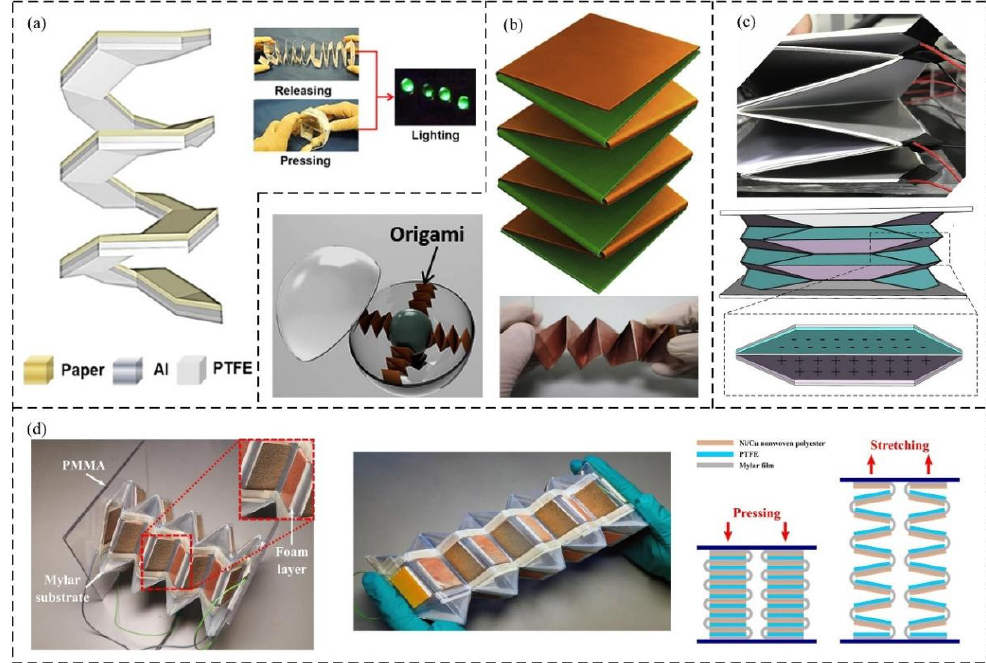
Figure 8. Multiple origami-type TENGs. ( a ) Schematic diagram and physical image of spiral paper-based origami TENG. Reprinted with permission from Ref. [120]. Copyright 2015 American Chemical Society. ( b ) Double-helix structure of stretchable TENG pressure sensor. Reprinted with permission from Ref. [121]. Copyright 2019 Elsevier. ( c ) Origami TENG applied in the field of intelligent transportation. Reprinted with permission from Ref. [122]. Copyright 2020 Elsevier. ( d ) TENG with polyester film based on origami structure. Reprinted with permission from Ref. [123]. Copyright 2021 Elsevier.